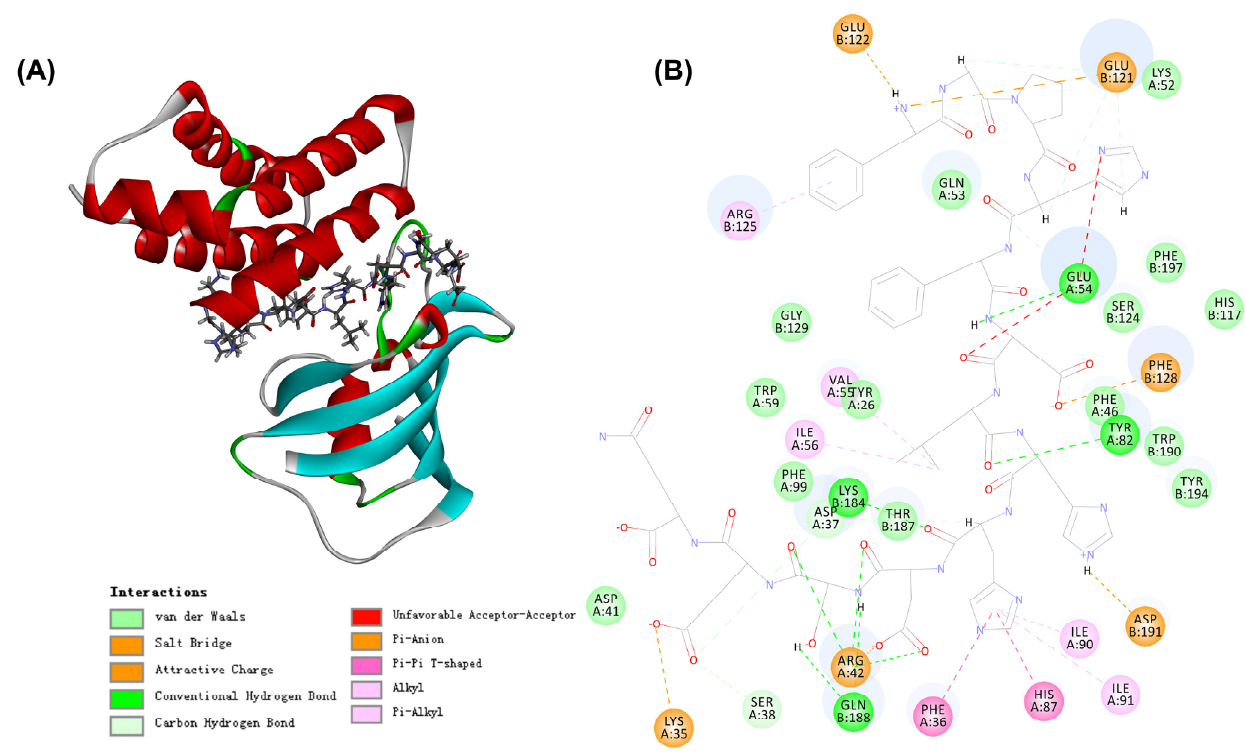
Figure 5. The 3D ( A ) and 2D ( B ) diagrams of the interactions between ADLETYLLEKSRVT and FKBP12-FRB.